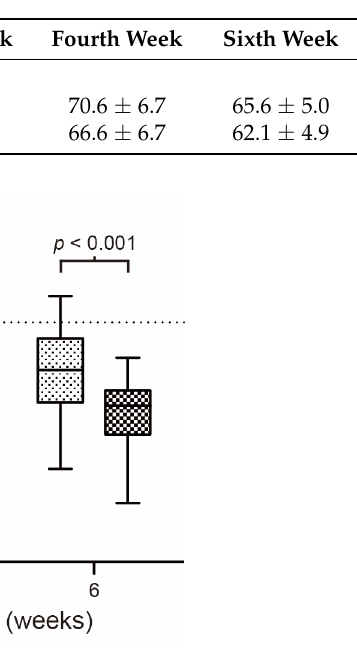
Figure 3. Percentage of body weight change at different time nodes of concurrent chemo-radiotherapy.